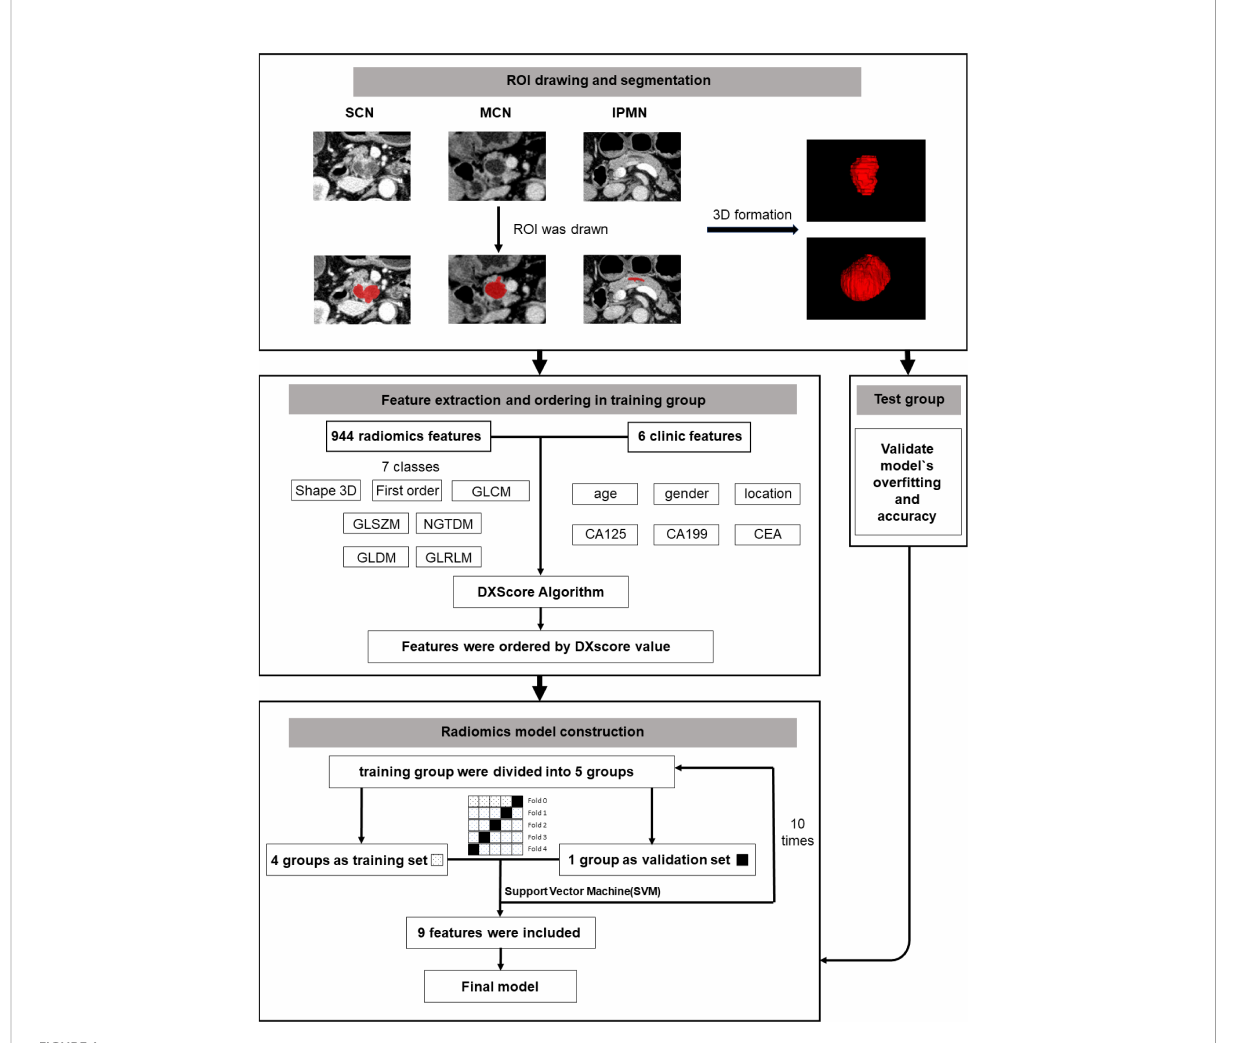
FIGURE 1 A general work fl ow of image processing and model